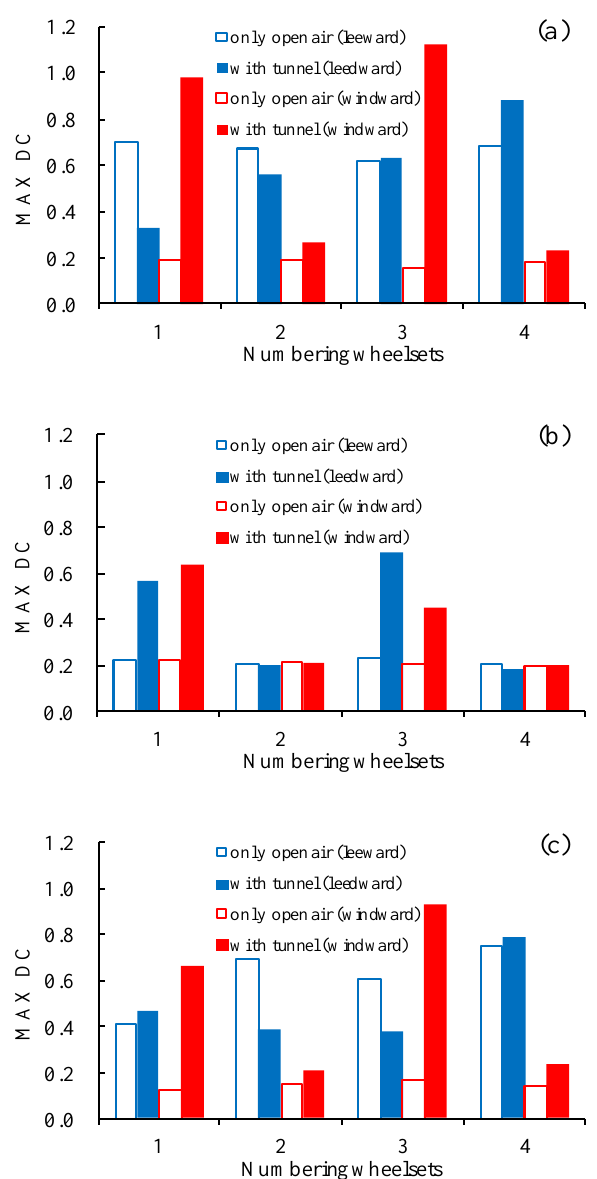
Figure 19. Contrast of global maximum derailment coefficients conditioned train speed 250 km/h, crosswind velocity 25 m/s: ( a ) head, ( b ) middle, and ( c ) rear carriages.